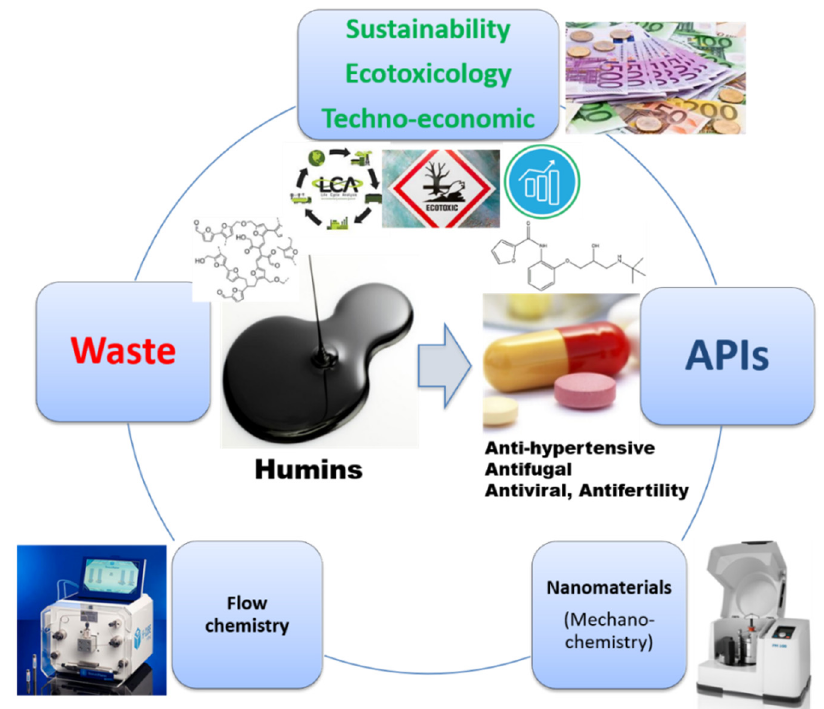
Figure 1. Project concept: from waste to the next generation of bioactive furanics under sustainable premises. The synthesis of APIs from biomass-derived waste has the potential to be conducted using green technologies, including mechanochemistry, photocatalysis and continuous flow processes (flow chemistry).